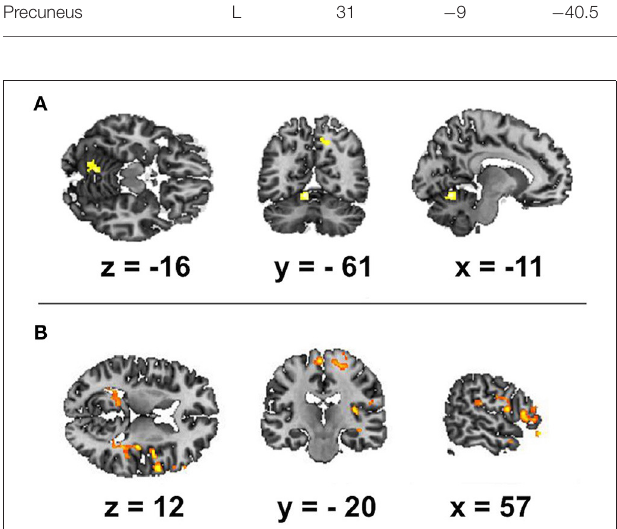
FIGURE 1 | Spatial brain maps with brain areas highlighted in which the BOLD signal increase showed a positive relation with the following EEG regressors: (A) frequency of alpha peak and (B) alpha band power. The figure shows the three most informative orthogonal slices for the EEG regressor. Activation (FDR corrected, p < 0.05, T < 3.47, cluster threshold > 100) is displayed in a gradient from red to yellow (3 < t < 7) on the scalp-stripped version of the average T1-weighted template image in neurological convention (left =